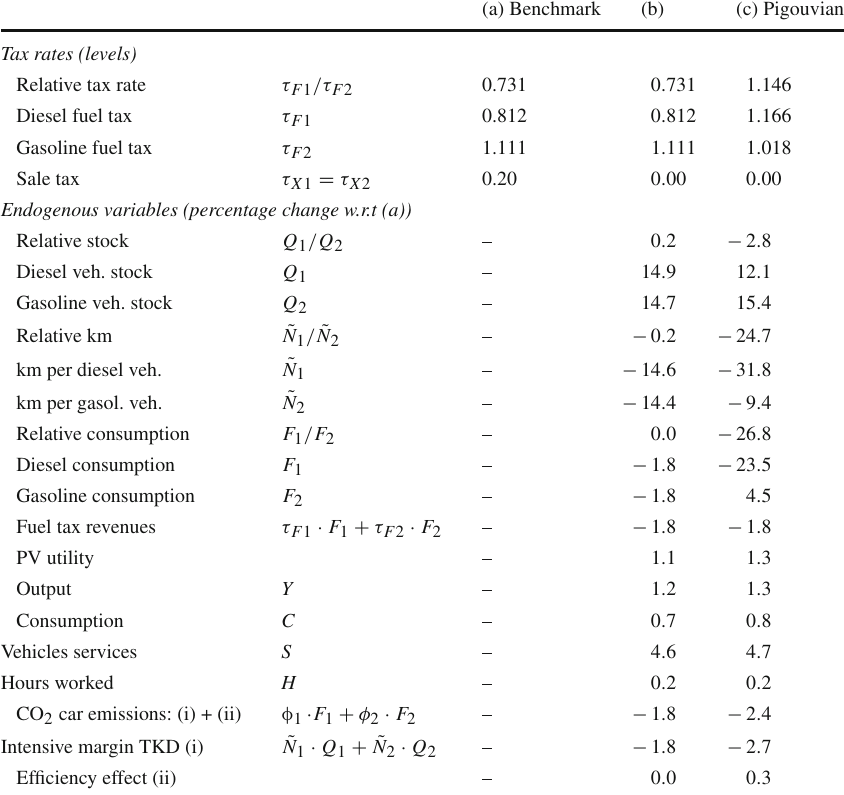
Table 7 Dieselization, traffic density and CO 2 emissions under alternative tax regimes (a) Benchmark (b) (c)